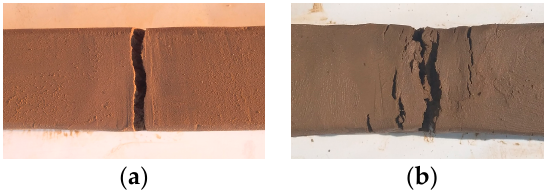
Figure 12. The transverse failure: ( a ) low water content; ( b ) high water content.